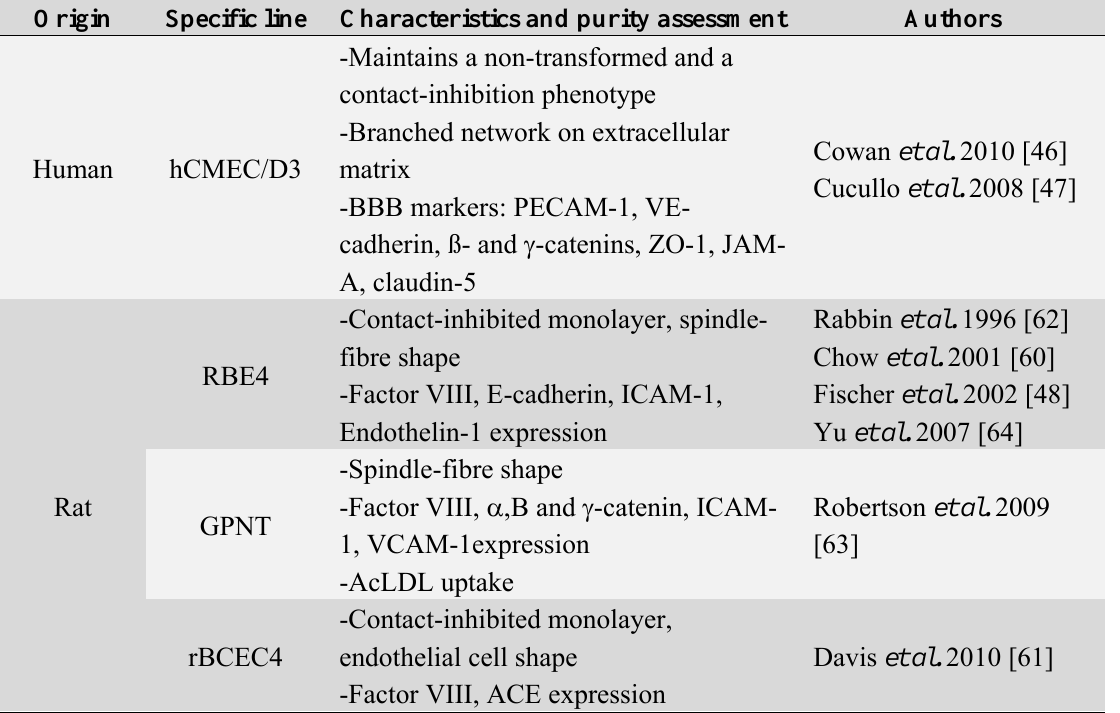
Table 3B. Studies performed with immortalized brain endothelial cells submitted to experimental